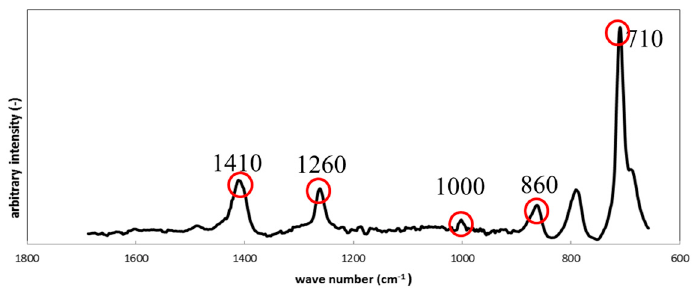
Figure 8. Raman shifts for the silicone specimen before immersion.